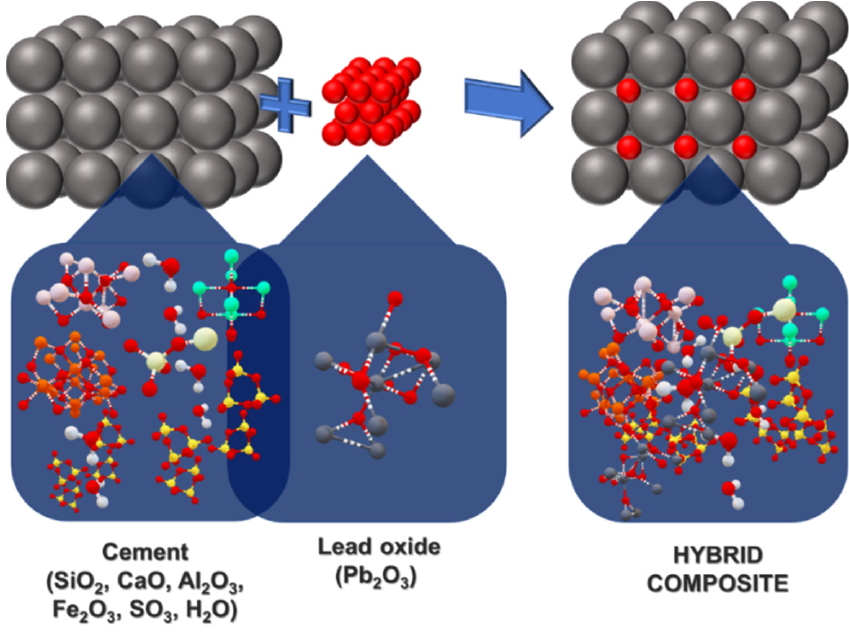
Figure 2. Pictorial representation of the development of hybrid nanocomposites.